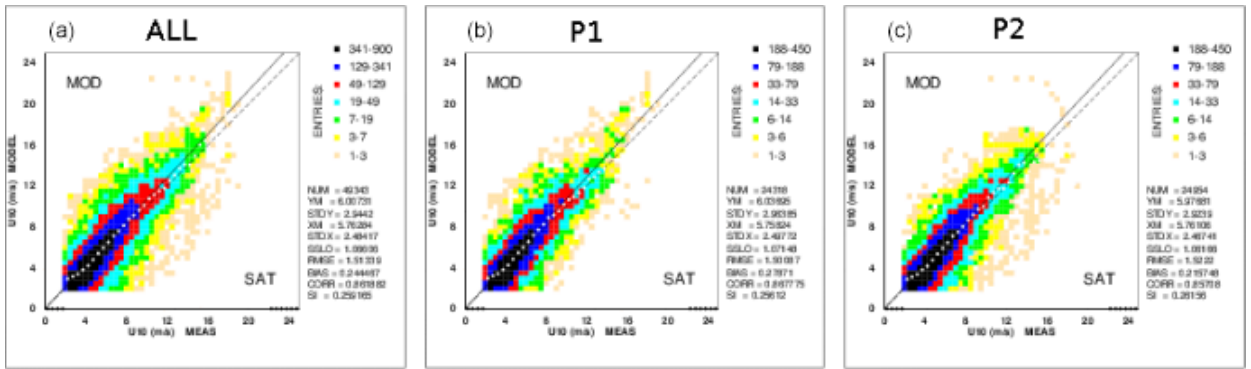
Figure 3. As in Fig. 1, but only for the Cryosat data. The full data set (a) and the two complementary halves of the data selected using random sampling (b, c) are